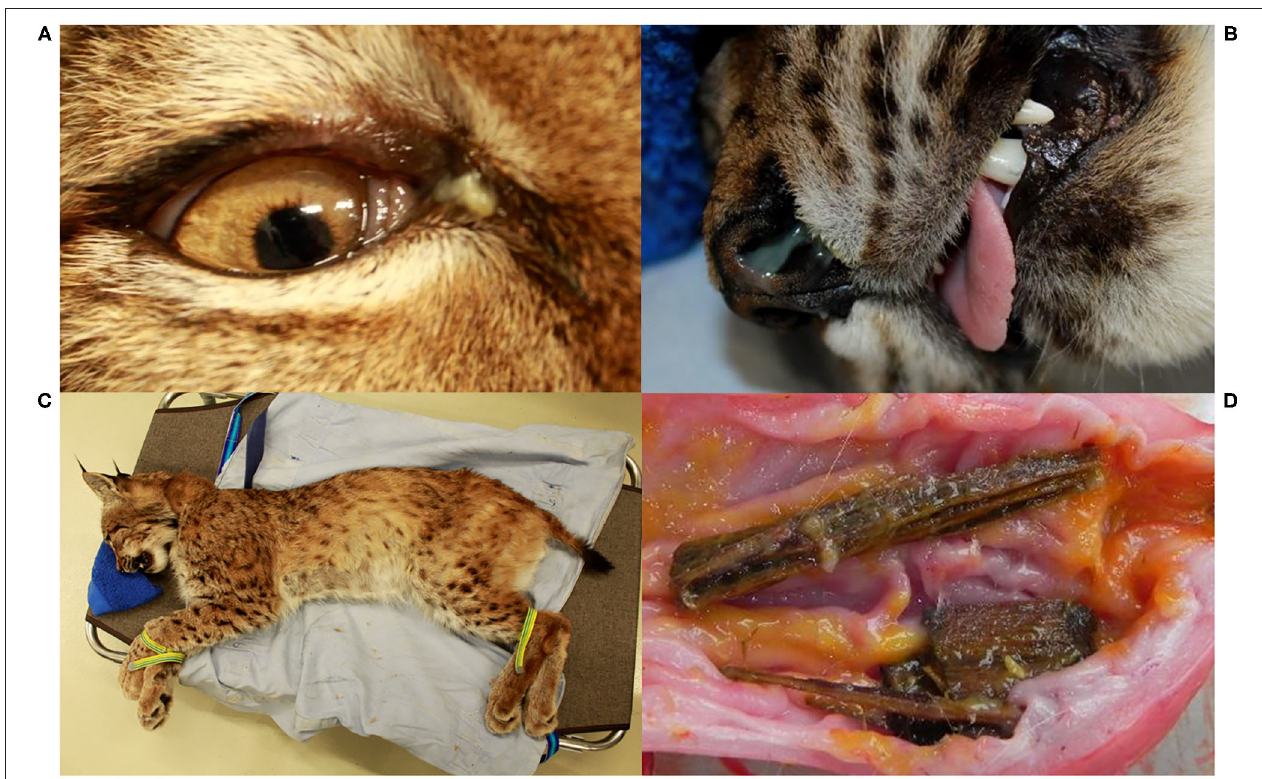
FIGURE 5 | Various body parts, Eurasian lynx ( Lynx lynx ), examination during quarantine; (A) Right eye, NAIA, and (B) Nose, SENI: mild purulent nasal discharge. (C) Coat, SENI: Hypotrichosis, mainly visible on the belly, caudal thigh and tail; (D) Opened stomach, NAIA: pieces of wood embedded in the mucosa and partly covered by yellowish